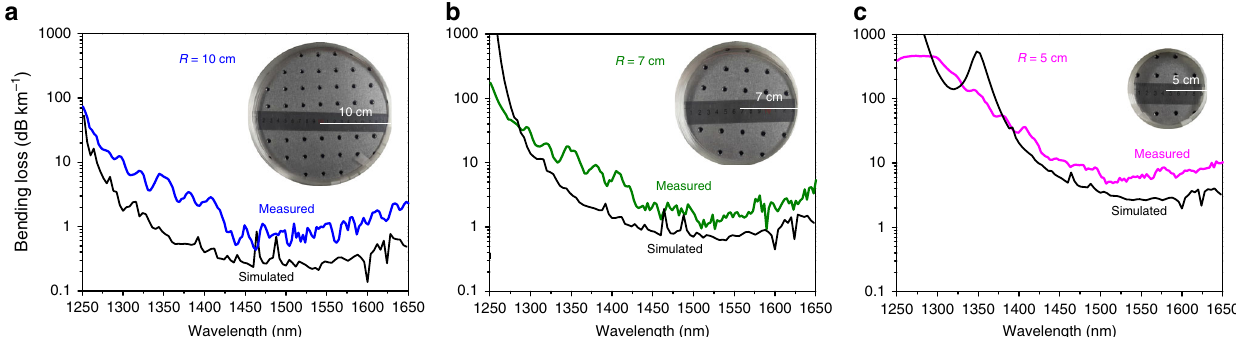
Fig. 2 Bending loss of the CTF. Measured and simulated bending loss spectra for a the bending radius R = 10 cm; b R = 7 cm and c R = 5 cm. Inset: Photo images of the fi bre under test with the loop numbers of 200, 270 and 390,